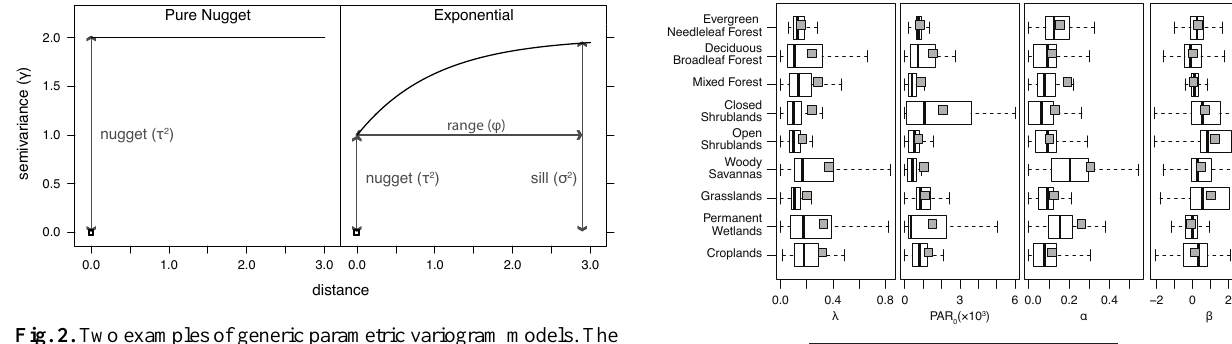
Fig. 2. Two examples of generic parametric variogram models. The parameter symbols correspond to Sect. 2.4 and Eq. (11). Because these are purely illustrative, units for semivariance and distance are irrelevant.